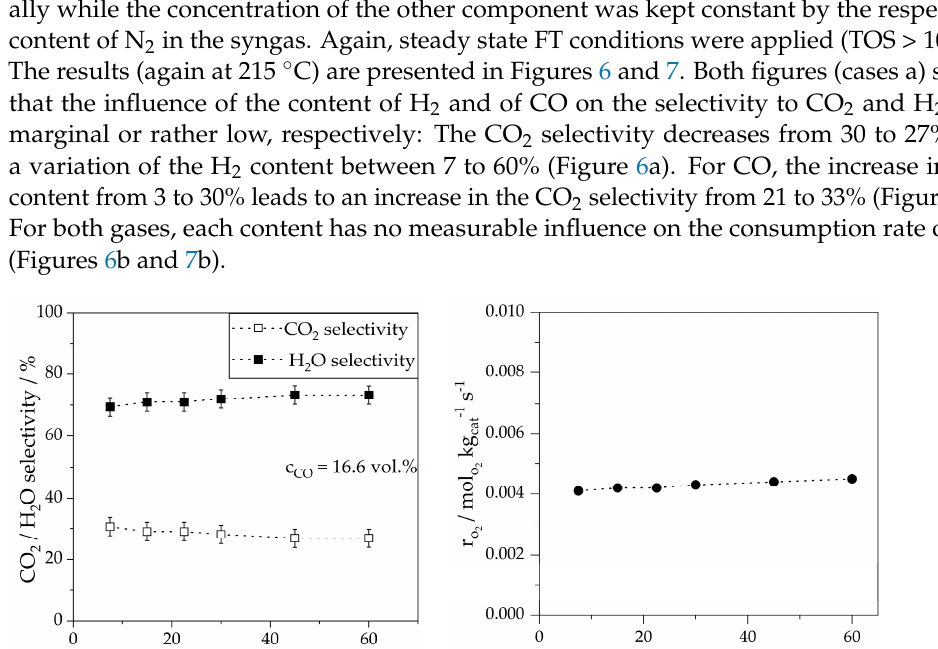
( b ) Figure 7. ( a ) Selectivity of O 2 products for different CO concentrations. ( b ) Oxygen reaction rate for different CO concentrations. Conditions: p = 20 bar; T = 215 °C; 𝑉(cid:4662) total = 15.9 L/h (NTP); p CO+N2 = 13.2 bar; p H2 = 6.6 bar; p O2 = 0.2 bar; m cat (Co/Pt/Al 2 O 3 ) = 1 g; X CO = 0.02; X O2 = 0.2. 3. Materials and Methods Two different sets of experiments were conducted to study the effect of oxygen on FTS: The change of mass of the catalyst was studied gravimetrical in a magnetic suspen- sion balance. In addition, the activity and selectivity of the catalyst both for FTS and con- version of the oxygen present in the syngas (to either CO 2 or H 2 O) were measured in a